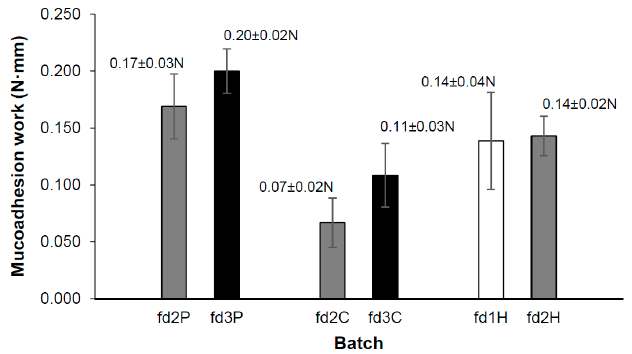
Figure 4. Average mucoadhesion work values for the freeze-dried batches.